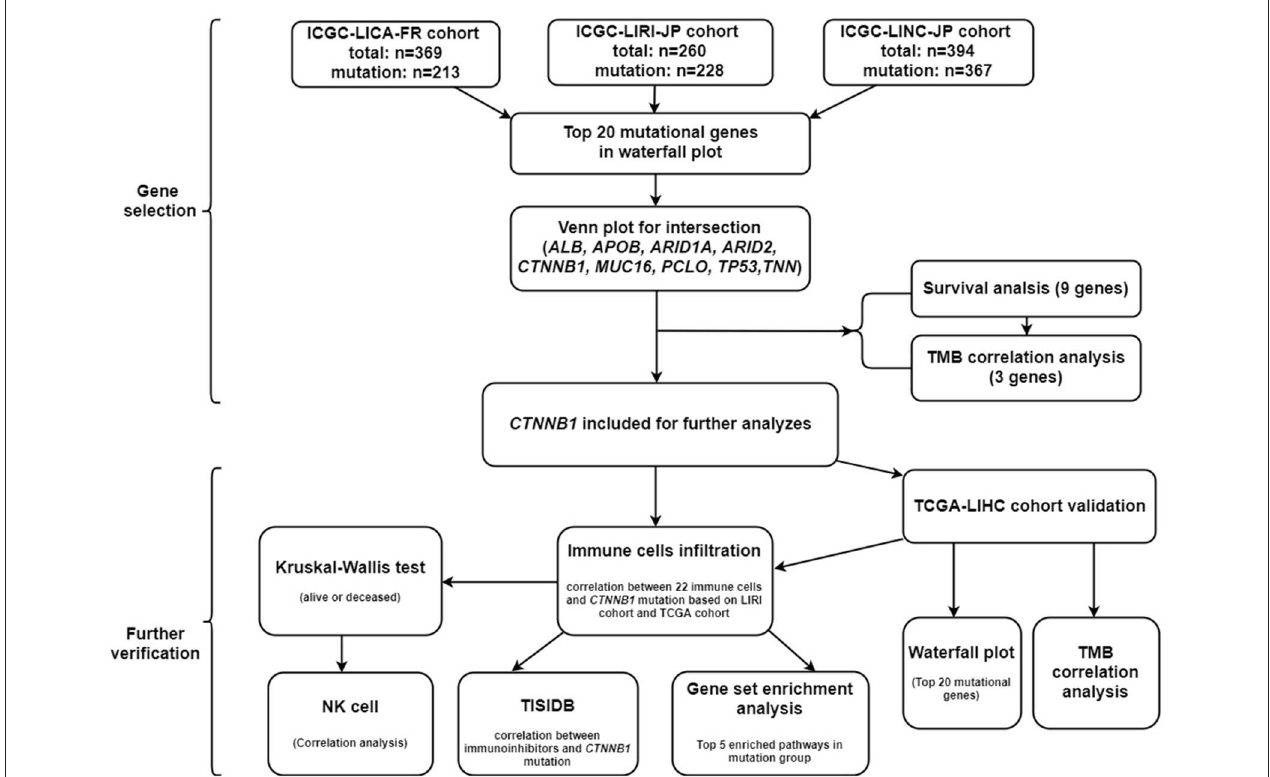
FIGURE 1 | The flowchart of this